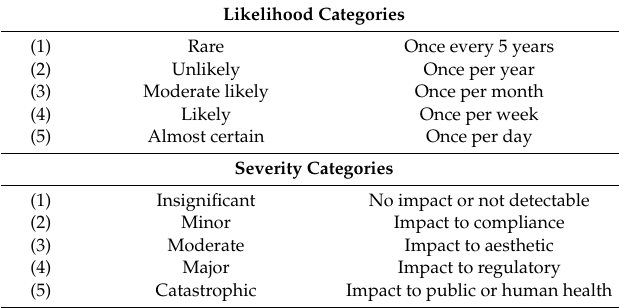
Table 2. Likelihood and severity categories in risk assessment for drinking water RMPs.